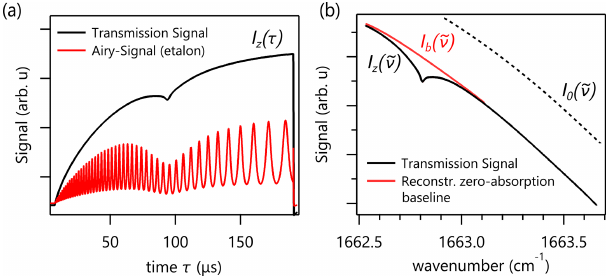
Figure 1. (a) The raw transmission signal through air (black) and a Fabry–Pérot etalon (red). The Airy signal is used to determine the frequency tuning of the laser. (b) After time-to-frequency conver- sion, the absorption line is fitted onto a subset of the data. Thereby, the baseline I b ( ˜ ν) is reconstructed, which, in contrast to the laser output intensity I 0 ( ˜ ν) , includes broadband absorption